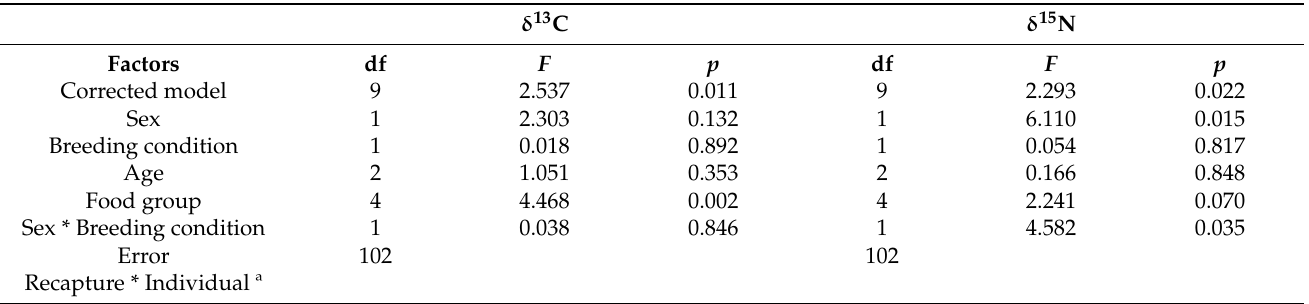
to food groups and individual factors.